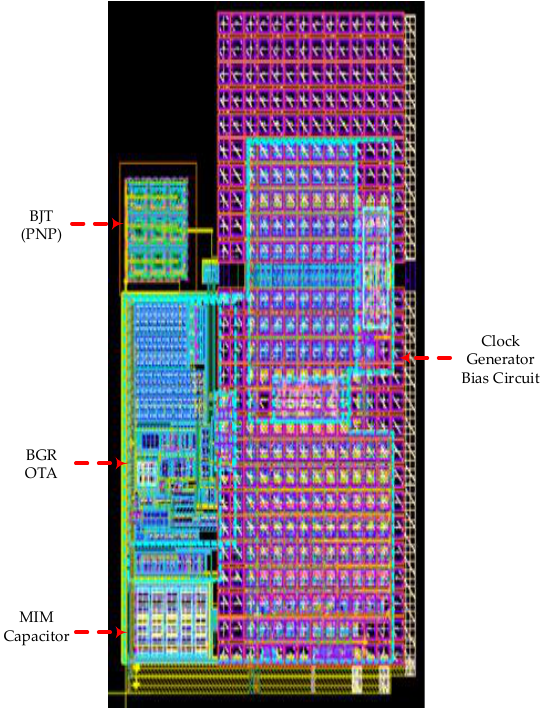
Figure 15. BGR with bias circuit sub-block layout (423.765 µ m × 315.825 µ m). The chip layout was generated through the 0.18 µ m CMOS process with dimensions of 285.25 µ m × 125.38 µ m. For better matching, a resistor layout was also created using a common centroid with dummies. At the same time, each resistor was constructed